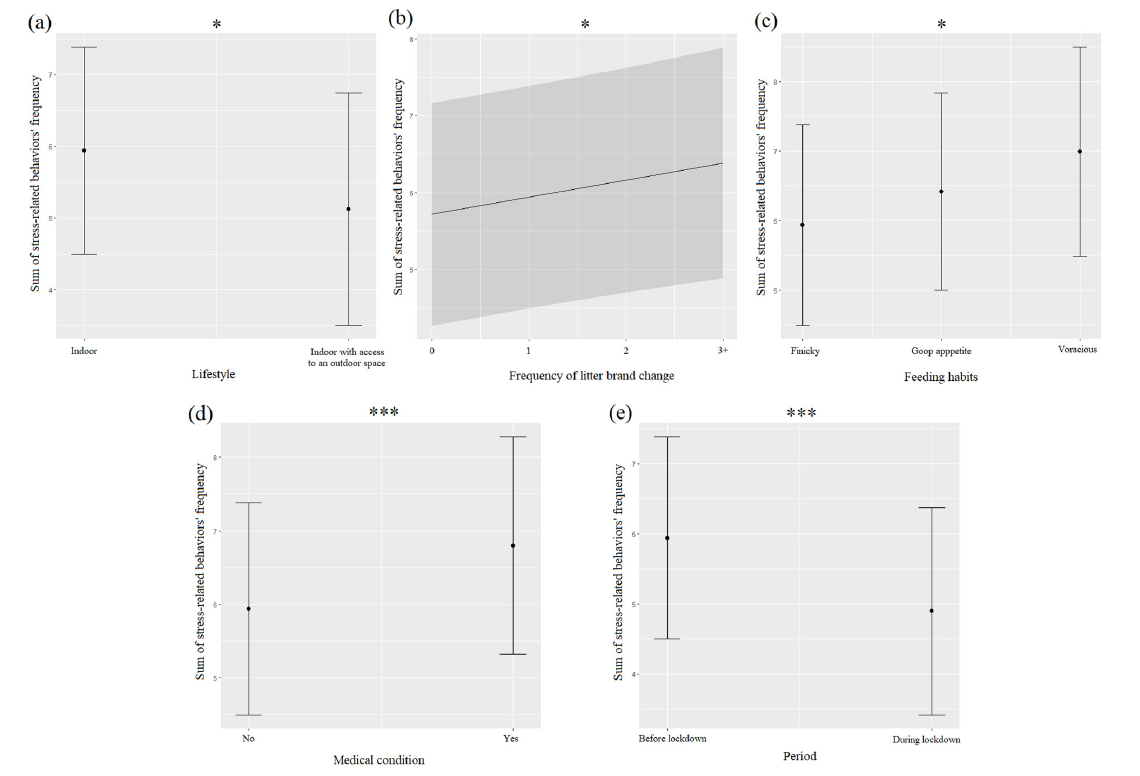
Figure 6. Means and 95% confidence intervals of cats’ stress-related behaviors’ frequency depending on cats’ lifestyle ( a ), frequency of litter brand change ( b ), feeding habits ( c ), medical condition ( d ), and the period ( e ) extracted from linear mixed-effect models (LMMs). *: p < 0.05; ***: p < 0.001, Wald chi-squared tests with Bonferroni correction.